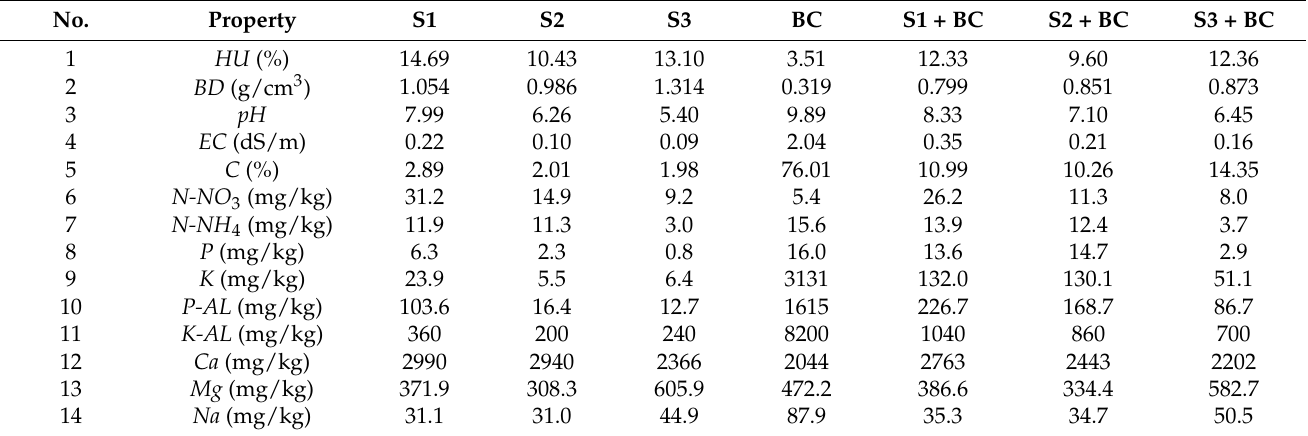
Table 2. Mean values of physicochemical properties of soils (S), BC, and BC-amended soils (S + BC).